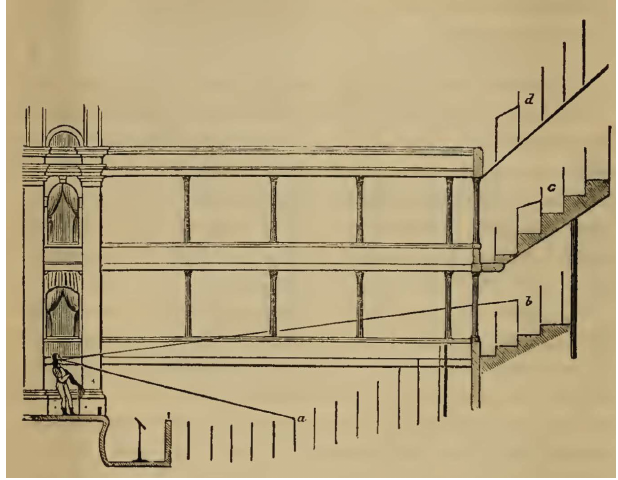
Figure 1. Illustration of calculation of optimum audience rake after Russell [16]. Positions a , b , c , and d represent the vertical elevations of individuals in different parts of the